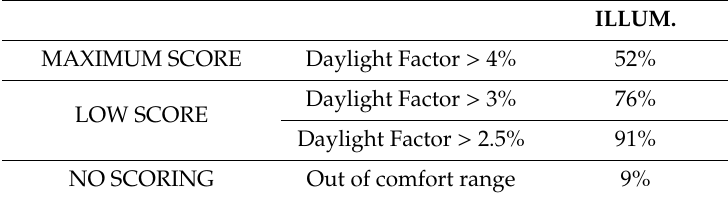
Table 7. Percentage of Hours (in scoring hours) in Lighting